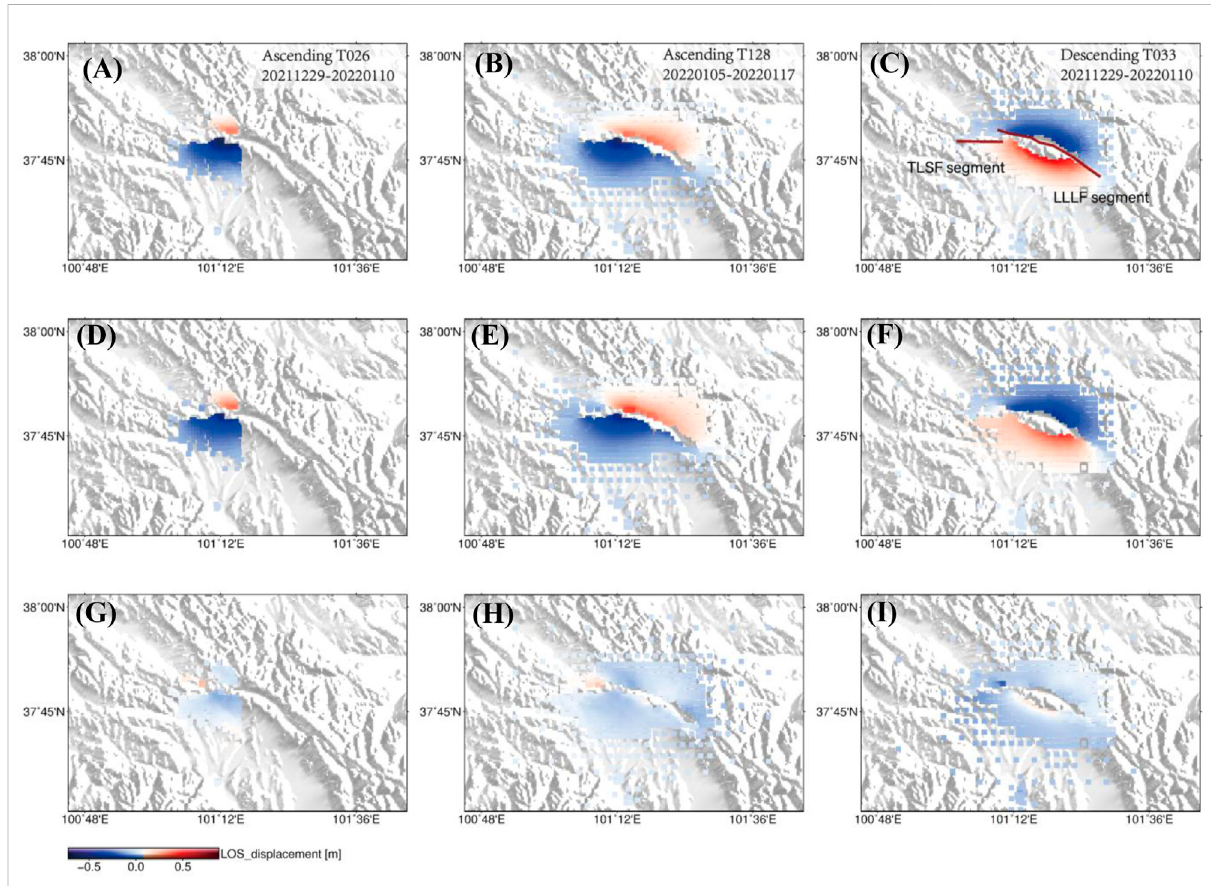
FIGURE 6 InSARobservationsafter atmosphericcorrection (A – C) ,models (D – F) ,andresiduals (G – I) forthethreetracks(26,128,and33)ininversion.The fault-traces of the TLSF and LLLF segments used for this slip inversion are indicated in red lines.